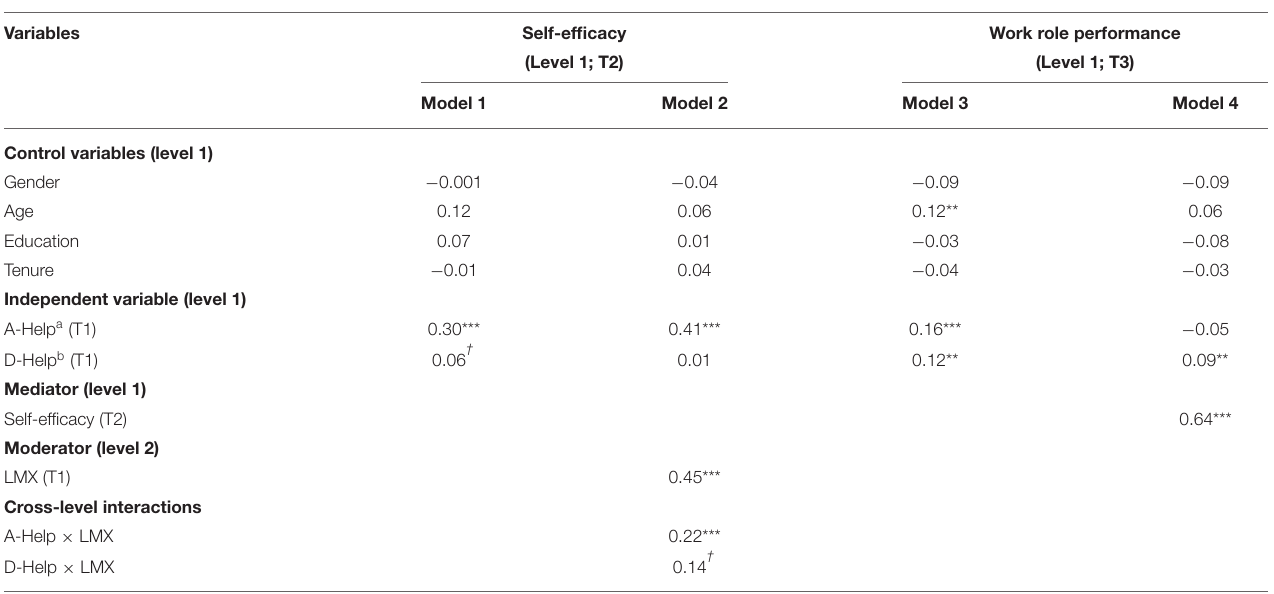
TABLE 2 | Unstandardized coefficients of the hypothesized model. Variables